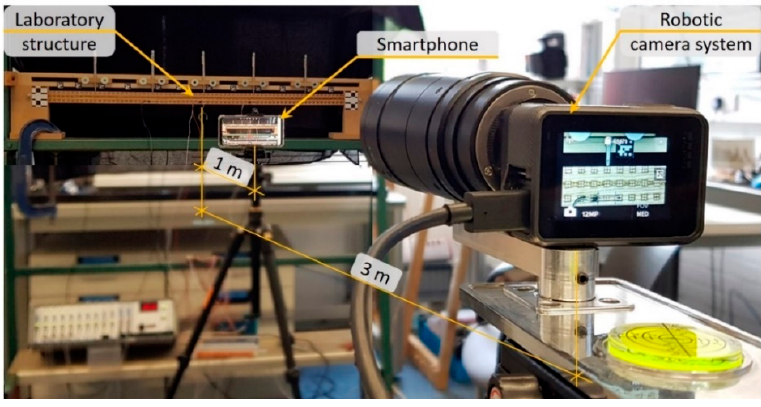
Figure 6. Experimental setup.